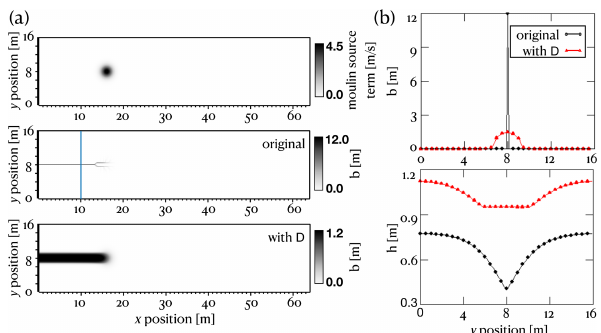
Figure 4. (a) Two-dimensional fields of moulin input and gap height ( b ) extracted from computations with mesh size (cid:49)x = 0 . 125m. (b) One-dimensional plots of gap height ( b ) and head ( h ) extracted from the two-dimensional fields, at location x = 10m, highlighted by the blue line in panel (a) . Note that original refers to the formu- lation without the diffusion term, while with D refers to the formu- lation including the diffusion